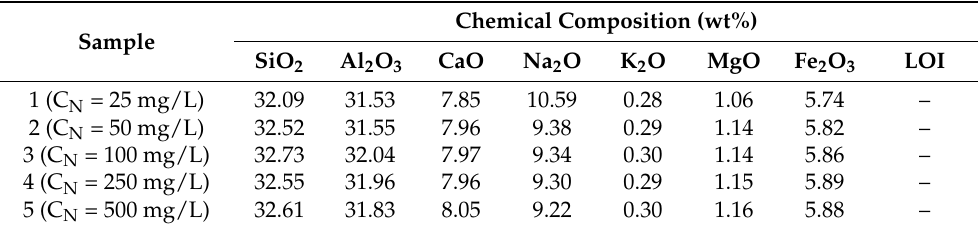
Table 2. Chemical constituents of SOD and adsorbed sediment slag